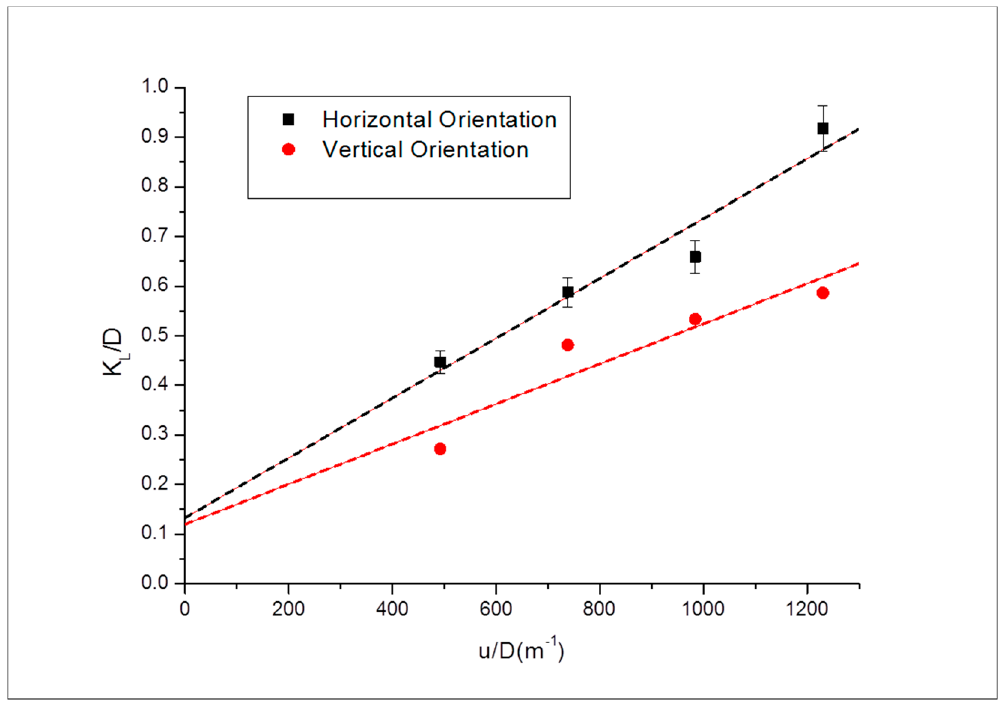
Figure 14. Comparison of the dispersivities in both orientations for Buff Berea.